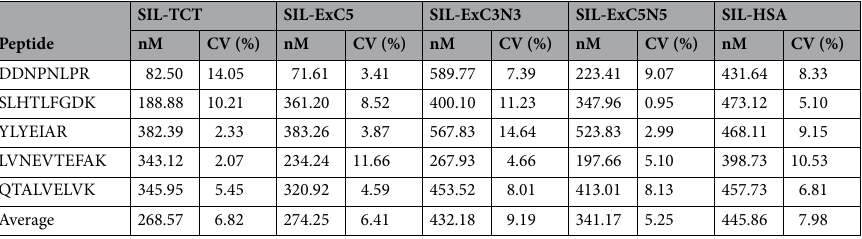
Table 1. The comparison of the quantitative performance of SIL-HSA and various types of SIL-Ex peptides (SIL-Ex were reconstituted in AmBic/SDC buffer with 5% ACN except for SIL-ExC5N5 indicating optimal quantitative performance in AmBic/SDC buffer with 50%